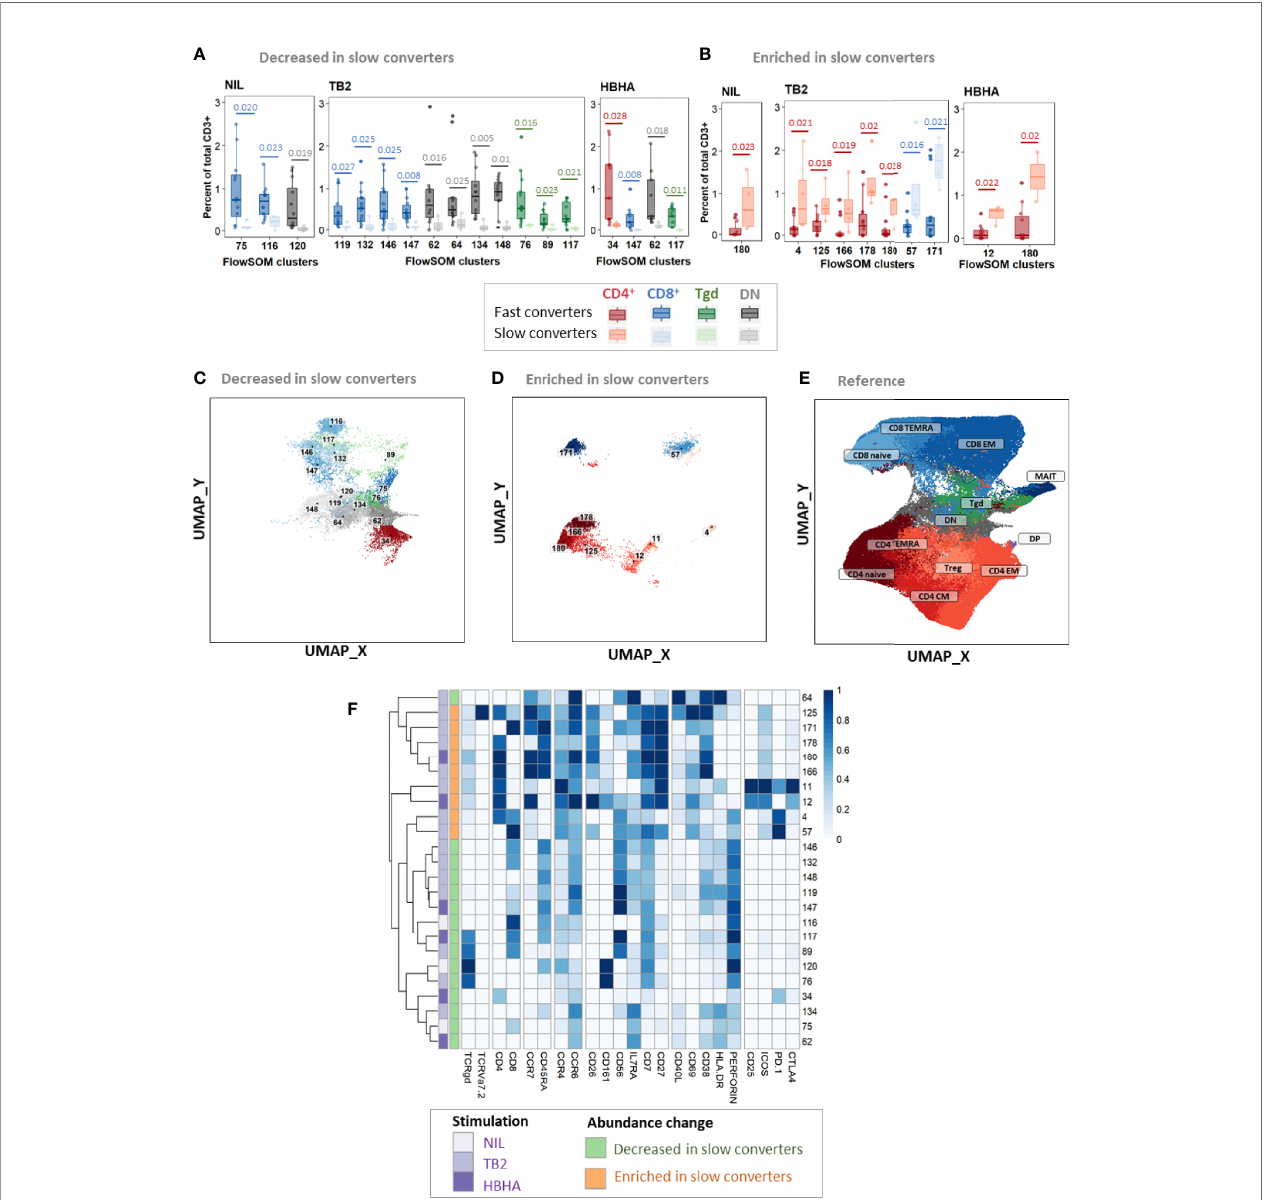
FIGURE 6 | Patients with slow microbiological culture conversion show decreased cytotoxic CD8 + and gd enriched CD4 + naïve T-cell subsets before treatment initiation and after two months of treatment compared to fast converters. Fast converters (n = 18) were de fi ned as patients with permanently negative M. tuberculosis culture after two months of treatment (T1), whereas slow converters (n = 4) were de fi ned as patients with persistently positive cultures at T1. The abundance of all FlowSOM clusters at baseline was compared between fast and slow converters. CD4 + clusters were represented in red, CD8 + clusters in blue, and gd T-cell clusters in green. Clusters which were signi fi cantly decreased (A, C) or enriched (B, D) at T1 in slow converters compared to fast converters were compared to the reference UMAP (E) . Normalized, arcsinh-transformed mean marker expression levels were visualized (F) . Each row represents one cluster. Scales indicate normalized mass signal intensity. Boxplot data represent medians + interquartile range. Statistical analysis: Only clusters within which differences passing a threshold of p<0.035 (Mann-Whitney U test) were represented. Exact, unadjusted p-values are indicated on the fi gures. Benjamini-Hochberg corrections for multiple comparisons were performed as an indication and were not used for cluster selection for phenotype analyses. Adjusted p-values did not reach signi fi cance. All adjusted p-values and complete test statistics are available in Supplementary Table 8